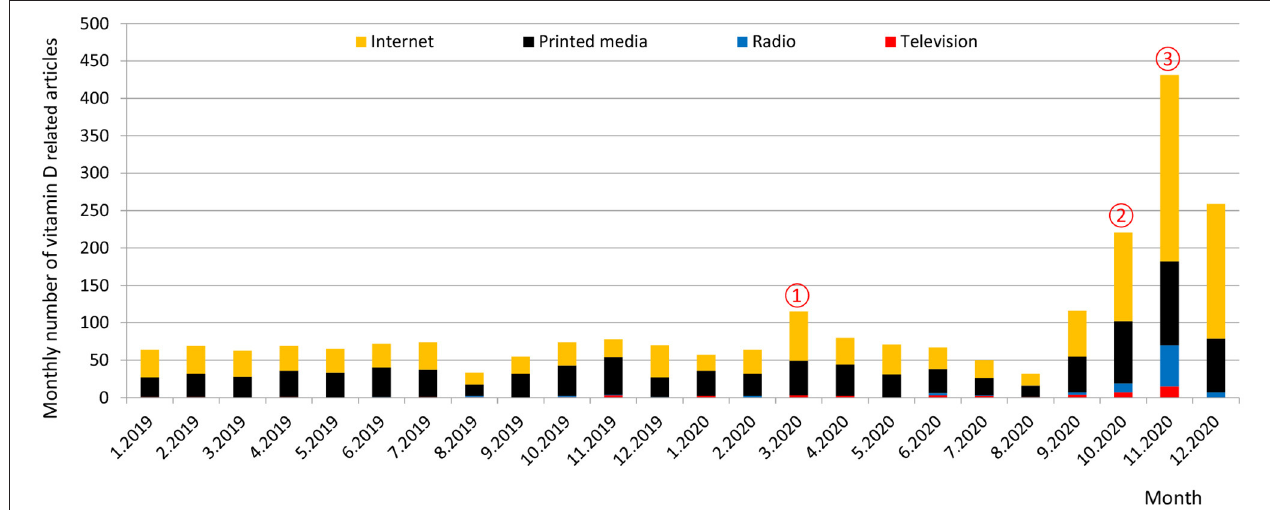
FIGURE 1 | A monthly number of vitamin D-related articles in Slovenian mass media in the years 2019 and 2020. This Figure 1 was constructed using the press coverage data of Kliping media agency (Slovenia), which collects full texts of publications from all relevant mass media channels in Slovenia [covering major television and radio stations (transcripts), print media, and internet portals]. Press coverage peaks correspond with: (cid:192) Media communication of physician D. Siuka about 10-steps in the fight against COVID-19 (44) ` Release of recommendations for supplementation with vitamin D for physicians (45) ´ Mass media intervention: Press release about the prevalence of vitamin D deficiency in Slovenia by the Nutrition Institute (46), followed by series of interviews and media reports.